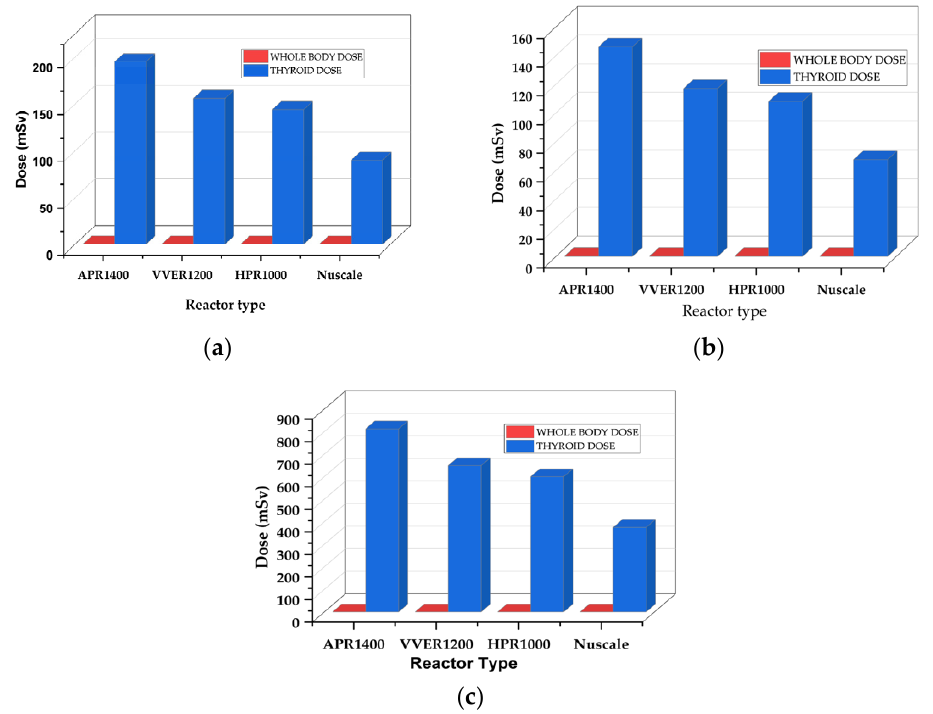
Figure 6. FHA whole-body and thyroid doses at the Exclusion Area Boundary, Low Population Zone, and Control Room Doses during fuel handling accidents. ( a ) represents doses at the exclusion area boundary. ( b ) represents doses at the low population zone. ( c ) represents doses in the control room. Figure 7 evaluated source term activities for long-term station blackout accidents.